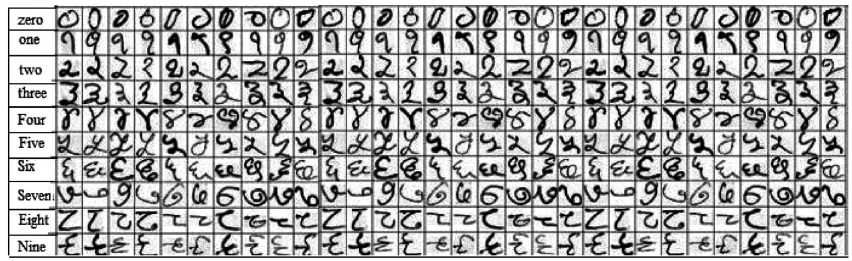
Figure 1: Illustration of Numeral Images with Several Intra-class Variations with Respect to Size and